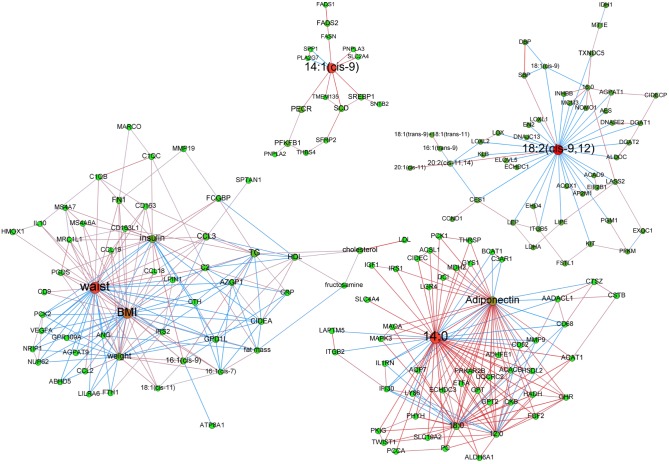
Adipose tissue networks of obese women after a 8-week low calorie diet.A sparse Graphical Gaussian Model (GGM) was used to estimate partial correlations in each set of variables and regularized canonical correlation analysis (CCA) was used to assess links between paired sets of variable. Clustering was performed using a spin glass model and simulated annealing. This analysis displays the variables that are connected independently from other variables. Graphs were laid out using force-based algorithms in Gephi 0.8.2 software. Nodes’ colors and font size indicate betweenness centrality. The red nodes have the highest betweenness and the green nodes the lowest one. Edge thickness is proportional to the strength of the correlation (CCA) or of the partial correlation (GGM). Edge color indicates the correlation sign: red for positive correlations and blue for negative ones. BMI, body mass index; CRP, C reactive protein; DBP, diastolic blood pressure; HDL, high density lipoprotein; LDL, low density lipoprotein; SBP, systolic blood pressure; TG, plasma triglycerides; waist, waist circumference.